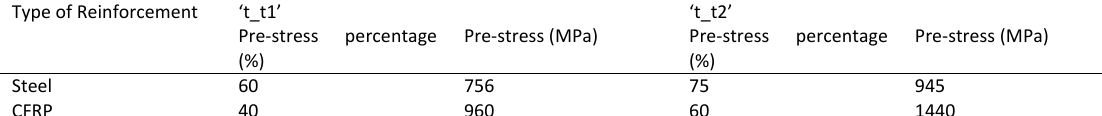
Table 4. Adopted pre ‐ stress percentage of the yield stress of the steel (cables and connectors) and CFRP reinforcement.